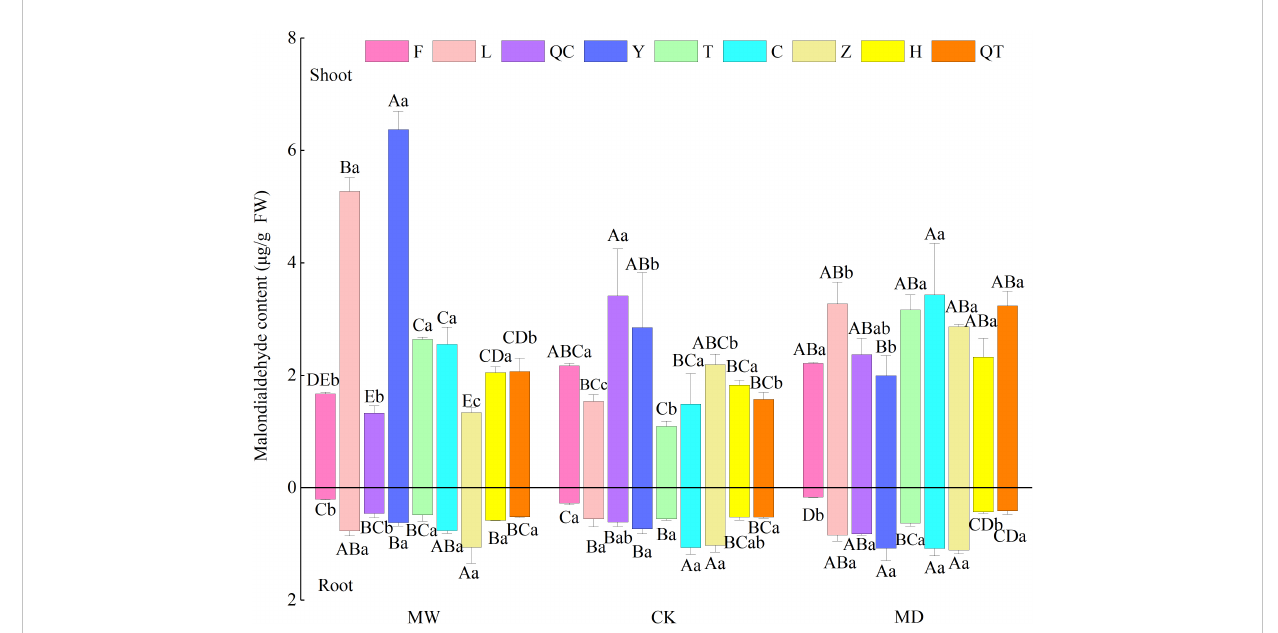
FIGURE 1 Malonaldehyde contents in leaves of nine selected plant species under different water regimes, including control (CK), moderate drought (MD) and moderate waterlogging (MW). Plant species include Deschampsia caespitosa (F), Poa crymophila Keng (L), Poa pratensis L. cv. Qinghai (QC), Festuca sinensis Keng ex S. L. Lu (Y), Puccinellia tenui fl ora (Griseb.) Scribn.et Merr.cv. Tongde (T), Elymus nutans Griseb. (C), Kobresia tibetica (Z), Blysmus sinocompressus Tang et Wang (H), and Carex moorcroftii Falc. Ex Boott (QT). Different lowercase letters indicate that there are signi fi cant differences between water regimes for the same plant species at P <0.05, different capital letters indicate that there are signi fi cant differences between plant species under the same water condition at P <0.05. Bars represent the standard error